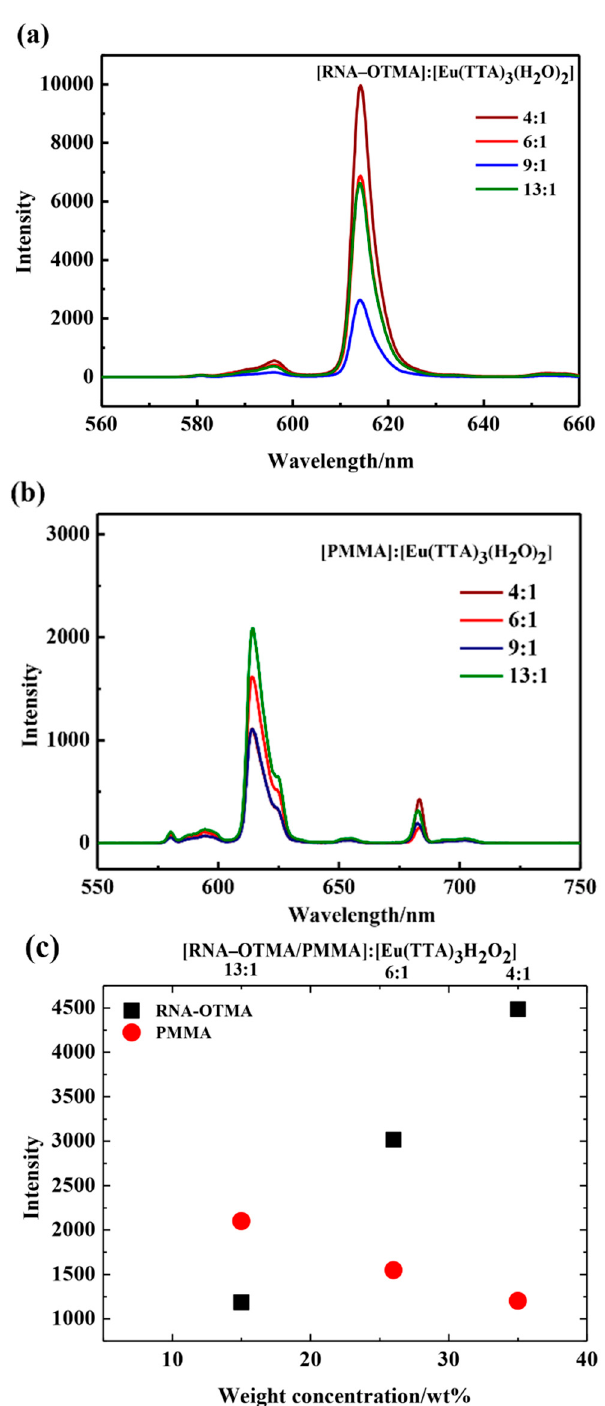
Figure 9. Fluorescence emission spectra of different concentrations of Eu (TTA) 3 (H 2 O) 2 complexes in ( a ) RNA–OTMA and ( b ) PMMA, and ( c ) dot plots of fluorescence emission intensity of RNA– OTMA/Eu films and PMMA/Eu films at different concentration ratios. (The weight percentages of Eu (TTA) 3 (H 2 O) 2 complexes ranged from 15% to 35%, and the excitation wavelength was 339 nm). The fluorescence emission lifetimes and quantum yields of the films were measured to evaluate their photophysical characteristics. First, the effect of RNA–OTMA lipid complex